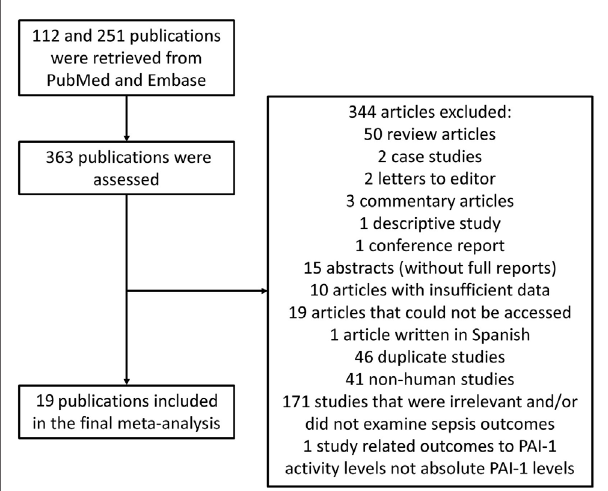
FigURe 1 | Flow diagram of the study selection process for studies investigating the association between plasminogen activator inhibitor-1 (PAI-1) and outcomes in